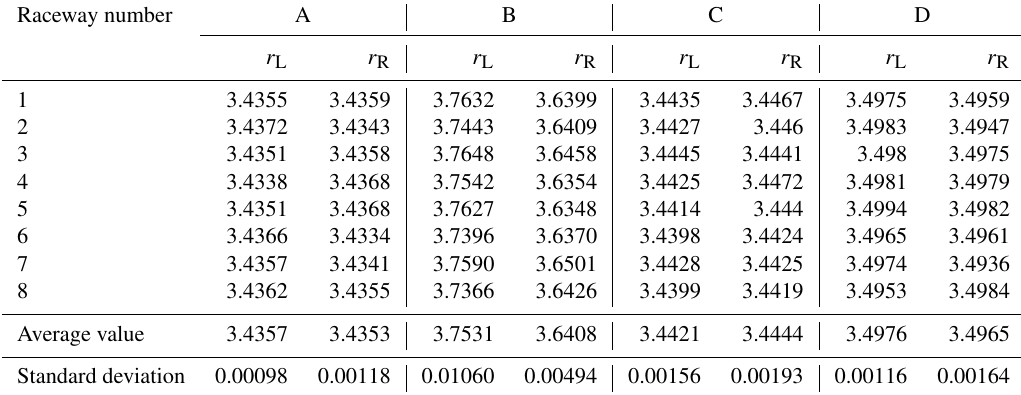
Table 2. Arc radius